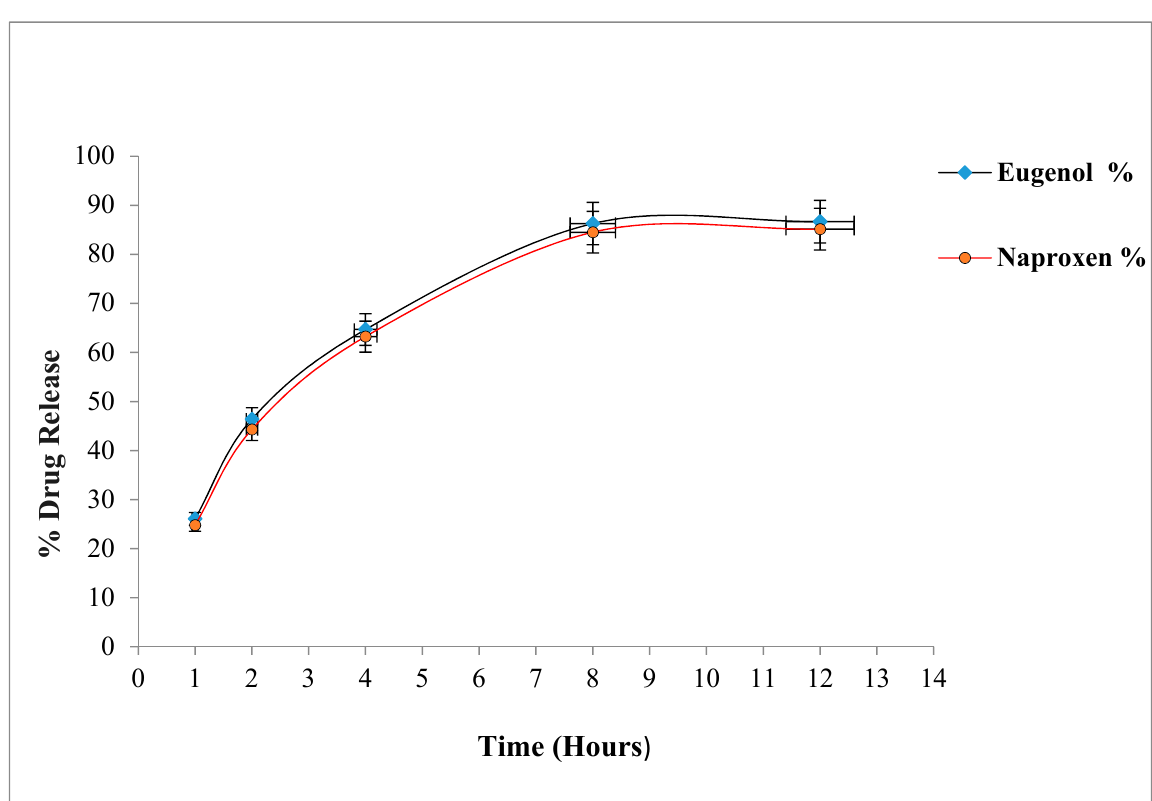
Figure 1. Percentage drug release of naproxen and eugenol from emulgel.